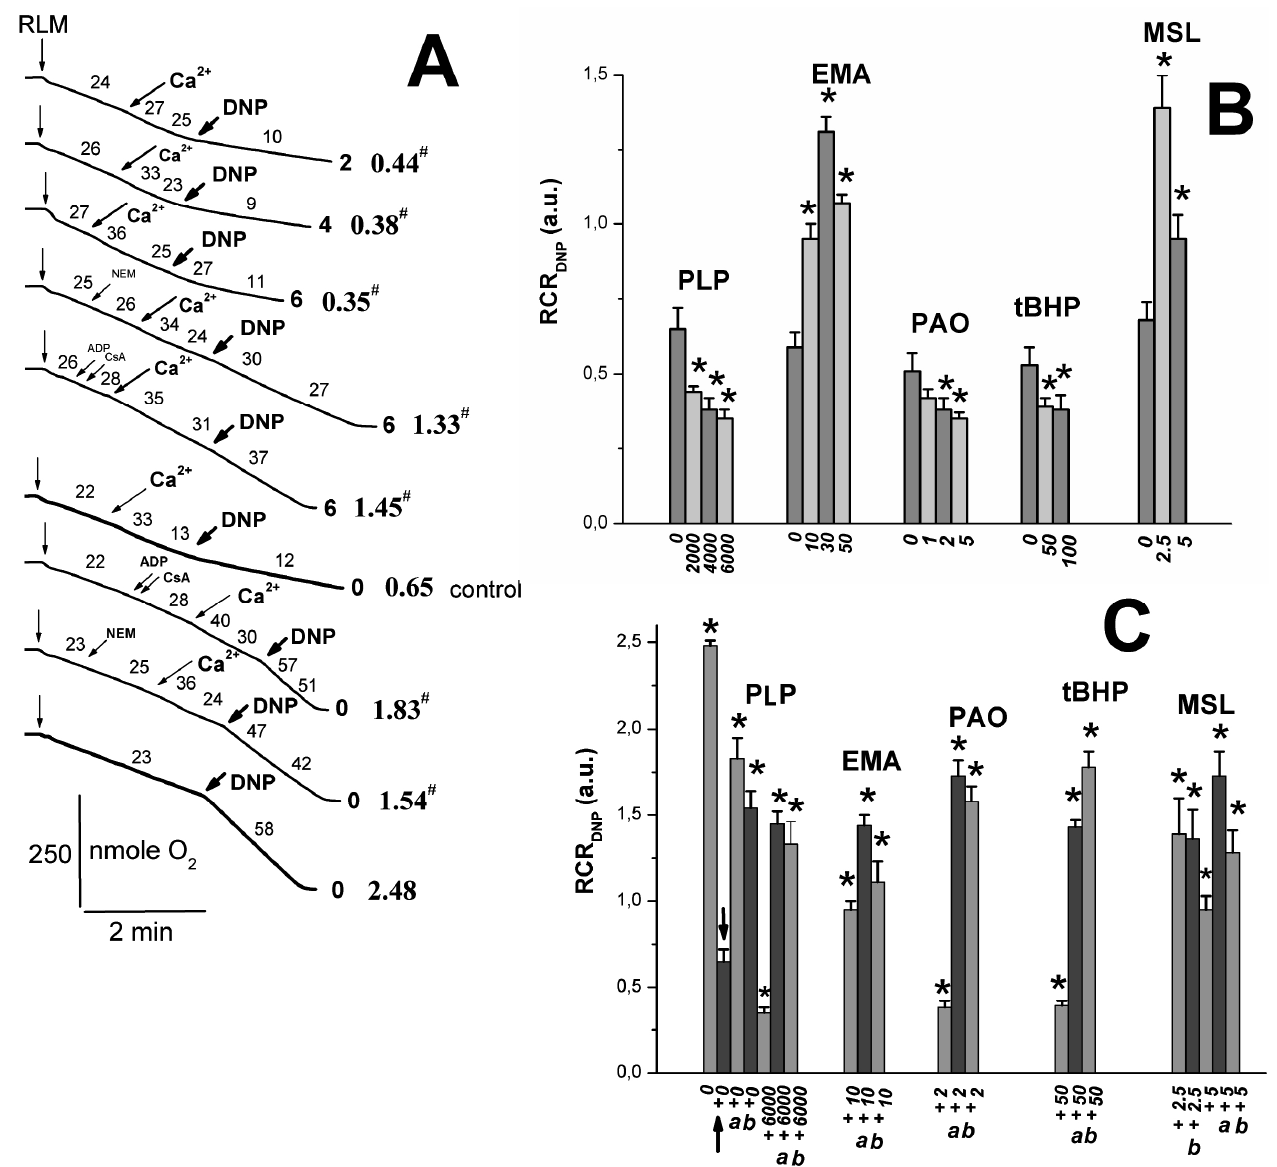
Figure 3. Effects of Ca 2+ , pyridoxal 5-phosphate, and thiol reagents on oxygen consumption rates of rat liver mitochondria. Mitochondria (1.5 mg/mL of protein) were added into a medium containing 75 mM TlNO 3 , 125 mM KNO 3 , 5 mM Tris-NO 3 (pH 7.3), 5 mM succinate, 2 μM rotenone, and 1 μg/mL of oligomycin. Additions of mitochondria (RLM), 100 μM Ca 2+ (Ca 2+ ), and 30 μM DNP (DNP) are correspondingly shown by the vertical arrows, inclined long arrows, inclined long bold arrows, and bold arrows. Inclined arrows indicate additions of 500 μM ADP (ADP), 1 μM CsA (CsA), and 50 μM NEM (NEM). The numbers ( A ) to the right of the traces show concentrations of PLP (mM). Oxygen consumption rates (nmole O 2 min/mg of protein) are presented as numbers placed above experimental traces. Numbers ( A ) to the right of the traces in bold show the value of the RCR DNP . Experiments free of additions ( A ) are indicated to the right of the traces: free of Ca 2+ and PLP (0) and 100 μM Ca 2+ alone (control). Representative traces from one of three independent experiments are presented. The ordinates ( B , C ) show RCR DNP values. Designations (with axes and concentration reagents) on panels ( B ) and ( C ) are the same as in Figure 2 (panels ( C , D )). The plus sign ( C ) indicates experiments with 100 μM Ca 2+ , and Latin letters ( a,b ) indicate experiments correspondingly with 500 μM ADP and 1 μM CsA ( a ) or 50 μM NEM alone ( b ), added after mitochondria as in panel ( A ). * shows significant differences ( p < 0.05) from the control (“0” under the abscissa) experiments free of thiol reagents (B) or Ca 2+ alone (C, column enclosed between arrows).